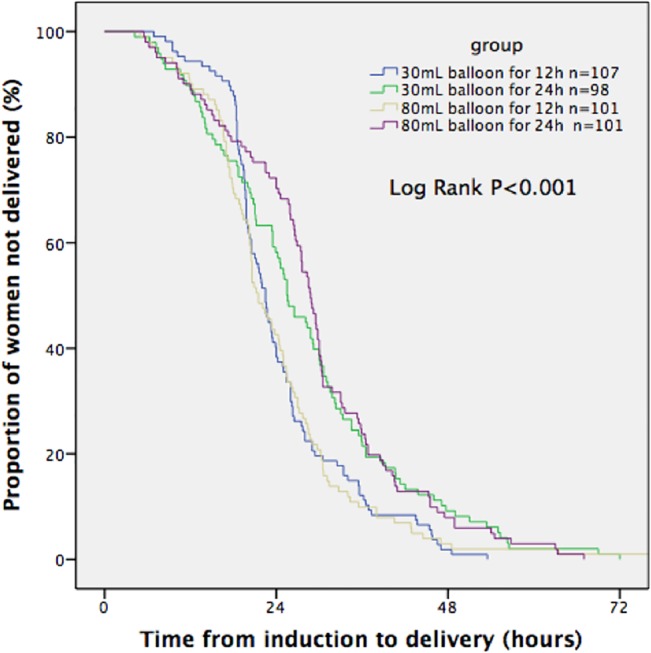
Time from start of induction to vaginal delivery (excluding cesarean deliveries).